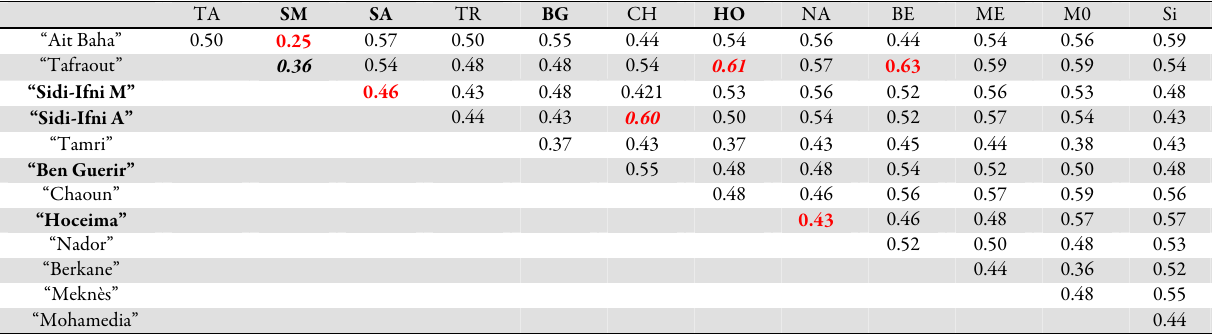
Table 4. FST value between pairs of cultivars, calculated with 10 SSR loci (All values were highly significant at p < 1%)